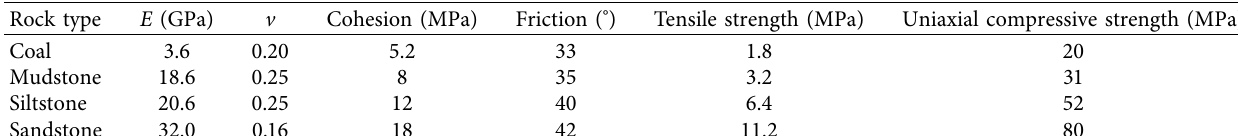
Table 1: Rock properties from the experimental test.